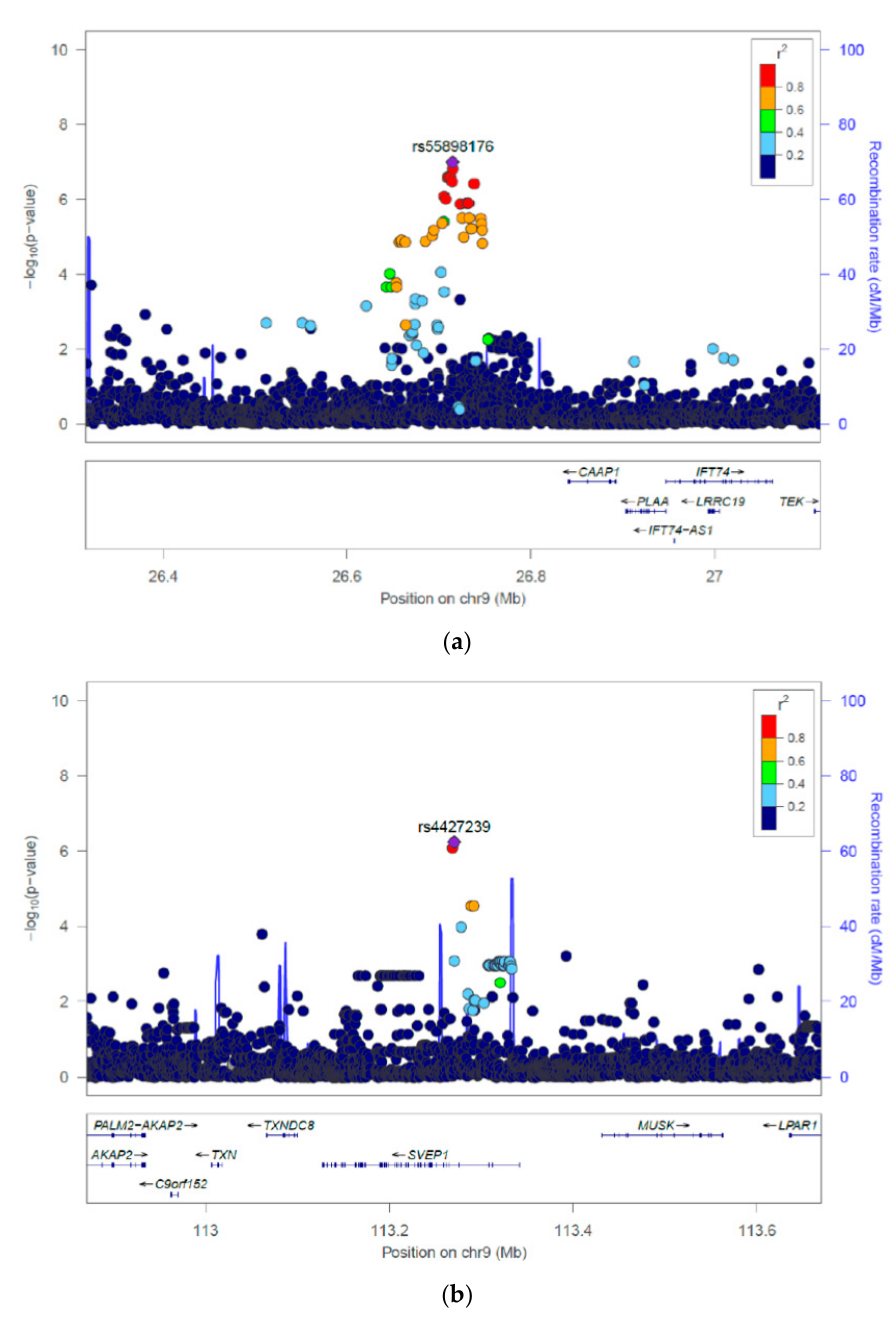
Figure 4. Regional association plots for regions around rs55898176 and rs4427239 . Plots were produced in Locus Zoom and show the most strongly associated independent SNPs: rs55898176 ( a ) and rs4427239 ( b ) from the GWAS meta-analyses of the 71 MIA cases versus 464 controls (tolerant and unexposed). Different colors represent the strength of the LD of each SNP with the most significant SNP represented by a diamond.